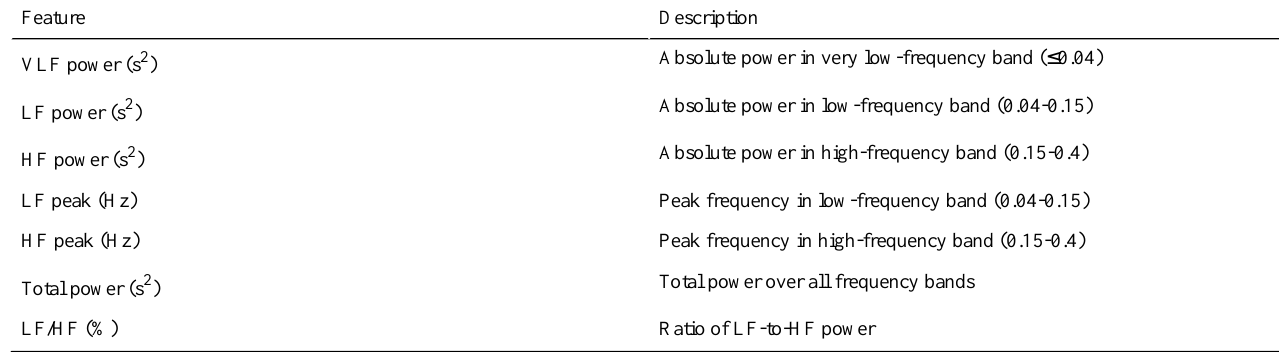
Table 2. Frequency domain heart rate variability features and their definitions.